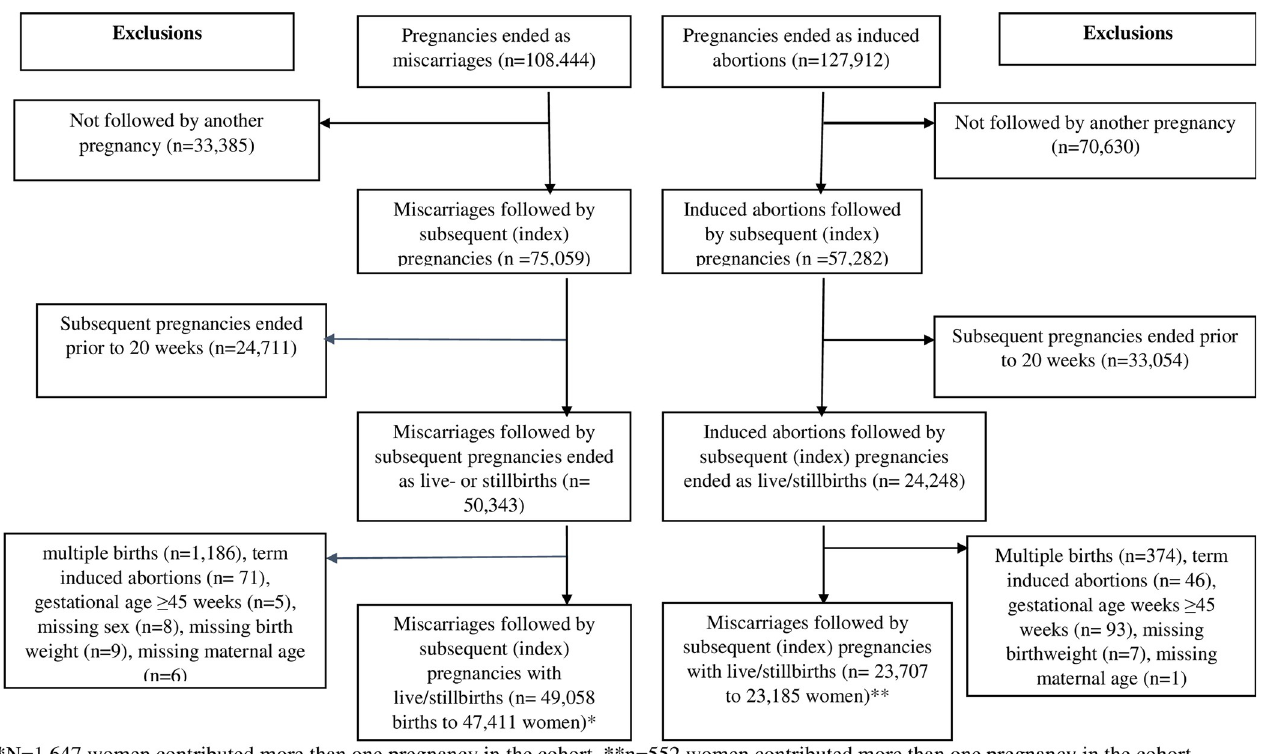
Fig 1. Flow chart for selection of births following miscarriages and induced abortions between 2008 and 2016 in Norway.